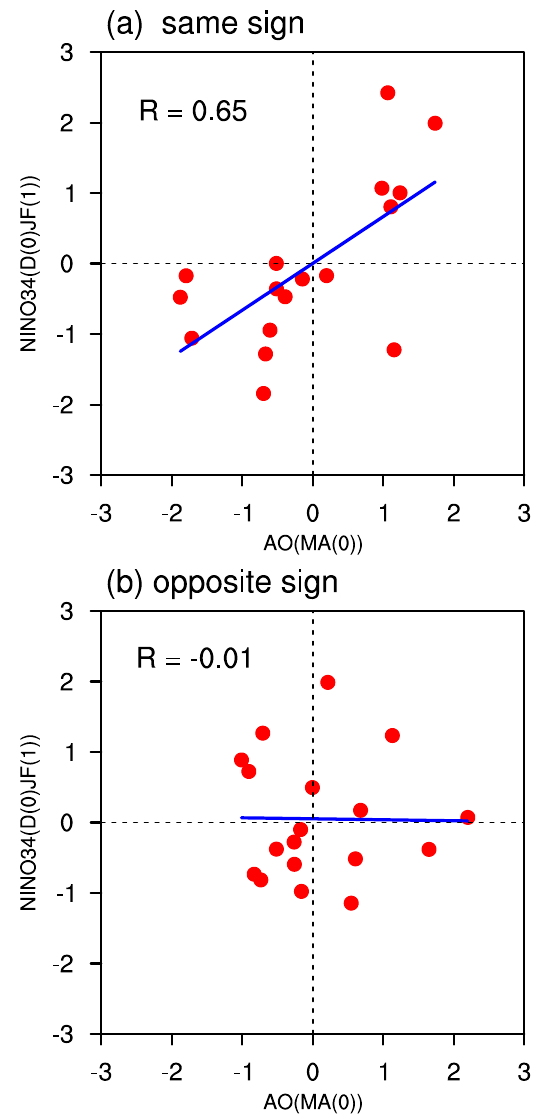
Figure 1. Scatterplots of the spring AO index with the subsequent winter Niño3.4 index, for the years when the spring AO index and the preceding November AO index have the ( a ) same and ( b ) opposite signs,